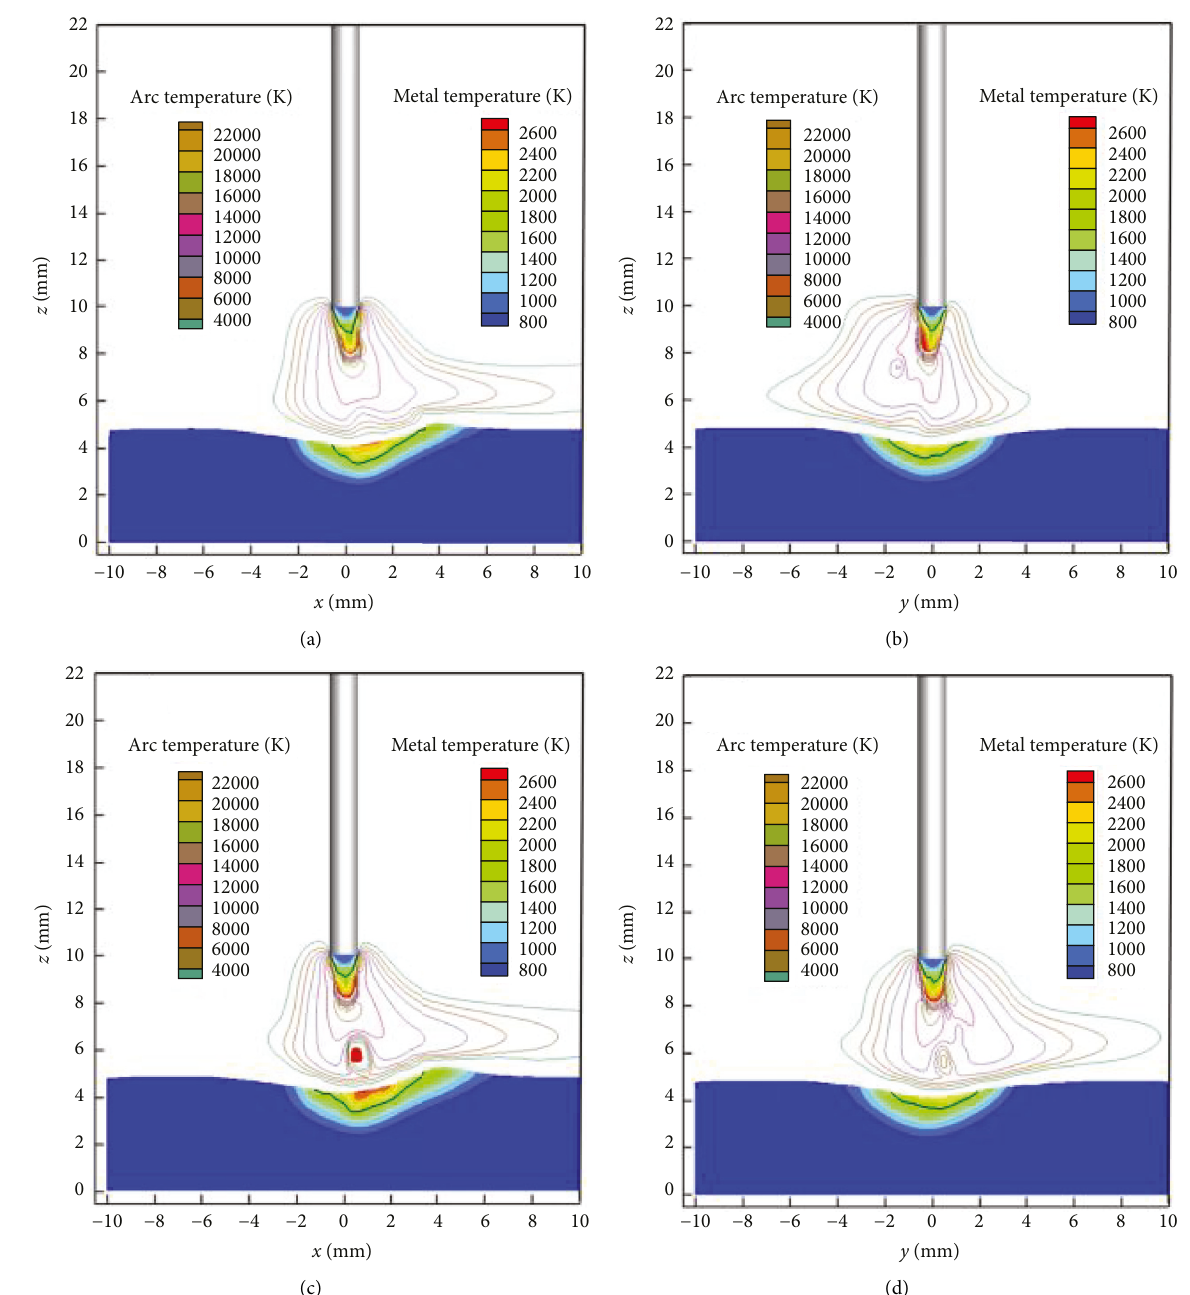
Figure 16: Simulated temperature distributions of the arc, droplet, and weld pool with EMF: (a) t 2 � 0.100 (s) xoz section; (b) t 2 � 0.100 (s) yoz section; (c) t 3 � 0.133 (s) xoz section; (d) t 3 � 0.133 (s) yoz